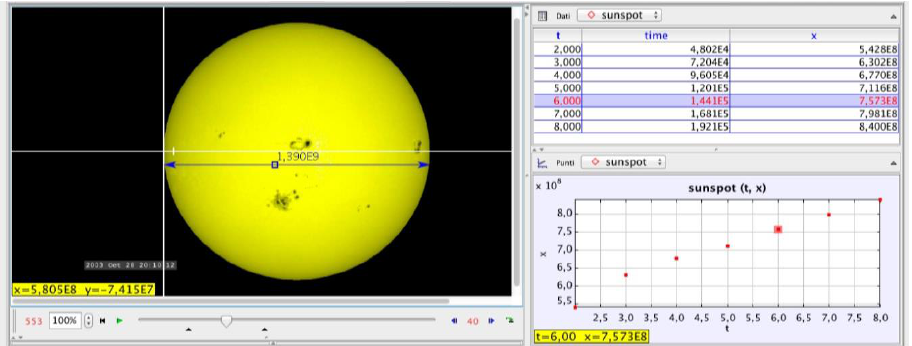
Fig. 1. Non calibrated spectrum curve of the Sun Fig. 2. Spectrum curve of the Sun light measured light measured from outside a window of the from space (source: http://va- classroom with Leybold spectrometer and Spectralab iitk.vlabs.ac.in/images/expt4/lines.png). software. Data are expressed in W/(m 3 ) 10 9 . Fig 3 . Tracker analysis of a video representing the motion of sunspots at equatorial latitude (https://svs.gsfc.nasa.gov/3502) during a two-week period in October and November of 2003, obtained with Michelson Doppler Interferometer (MDI). Left frame shows the tracking of the sunspot, right frame shows position vs. time graph and table of the sunspot. A linear fit gives an estimate of the Sun rotational velocity v = (1.9±0.1) 10 3 ms -1